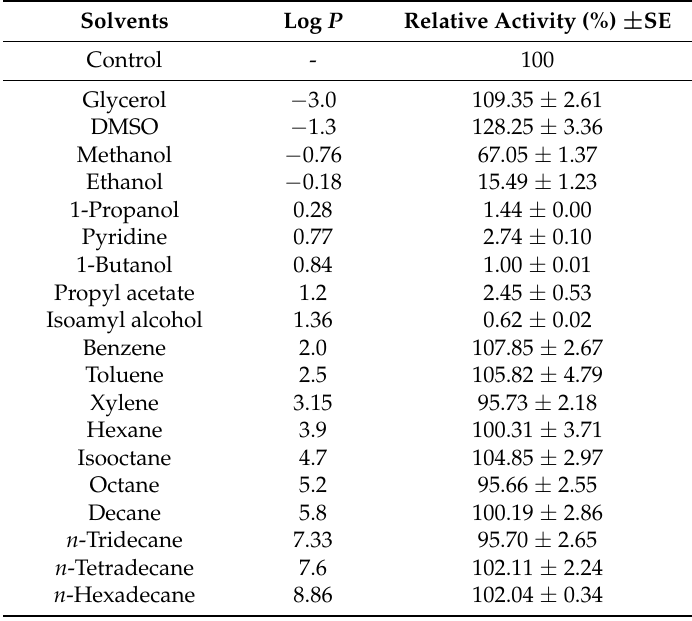
Table 6. Effects of organic solvent on the stability of the mature rHZ